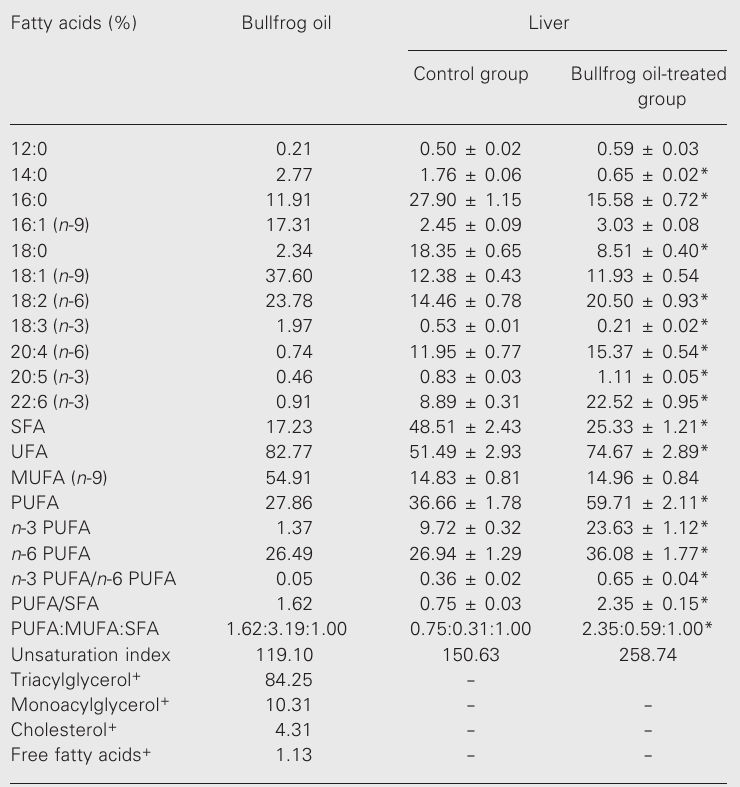
Table 1. Fatty acid composition of bullfrog oil and of the liver of bullfrog oil-treated mice. Fatty acids (%) Bullfrog